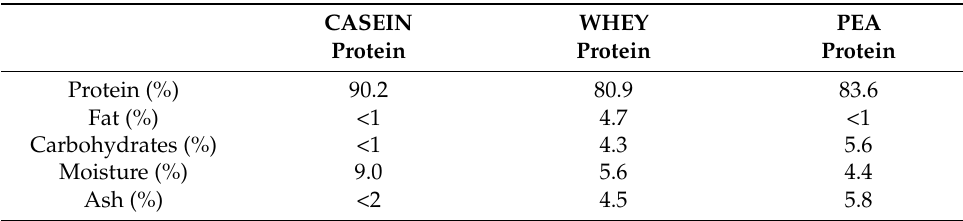
Table 2. Composition of the protein